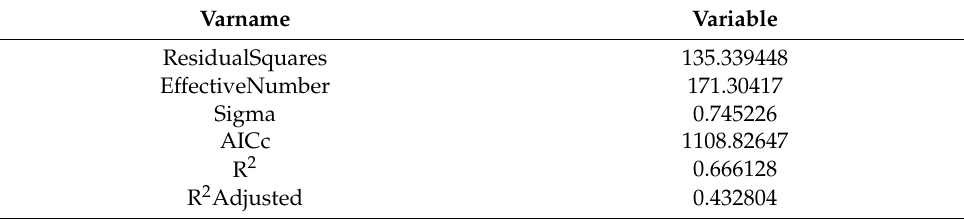
Table 3. GWR parameter table.